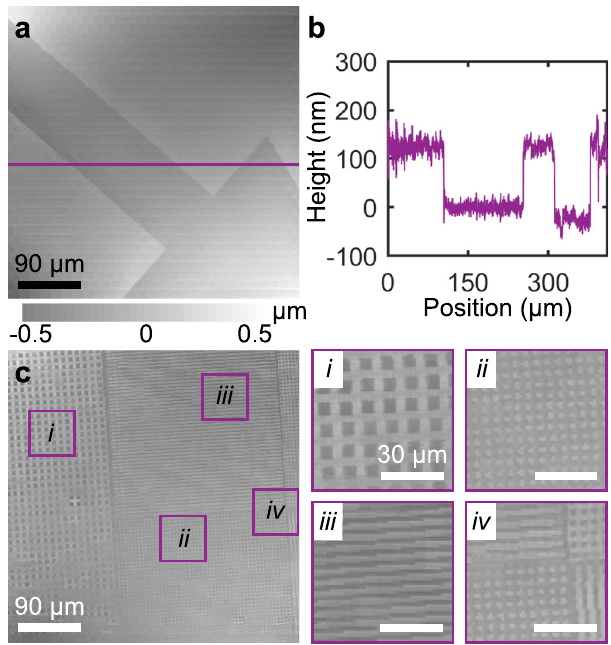
Fig. 4 Imaging with cantilever-free scanning probes. a Topographical image of an arrow region on a calibration grid imaged with 1 μ m horizontal resolution. b A height pro fi le of the arrow region taken with 100 nm horizontal resolution. Here, the vertical precision is estimated as the root- mean-square deviation of h in regions expected to be fl at and found to be 9 nm. c Cantilever-free AFM images of a complex region of the calibration sample with insets showing an assortment of lines, pits, and